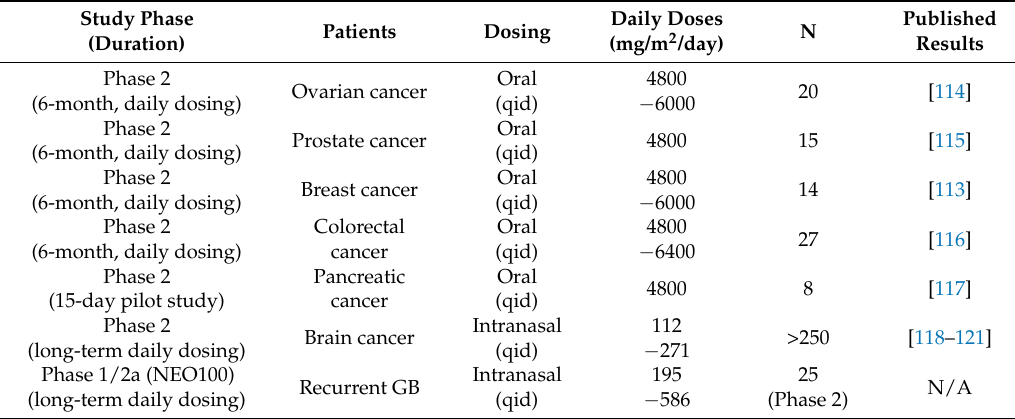
Table 1. Efficacy studies with perillyl